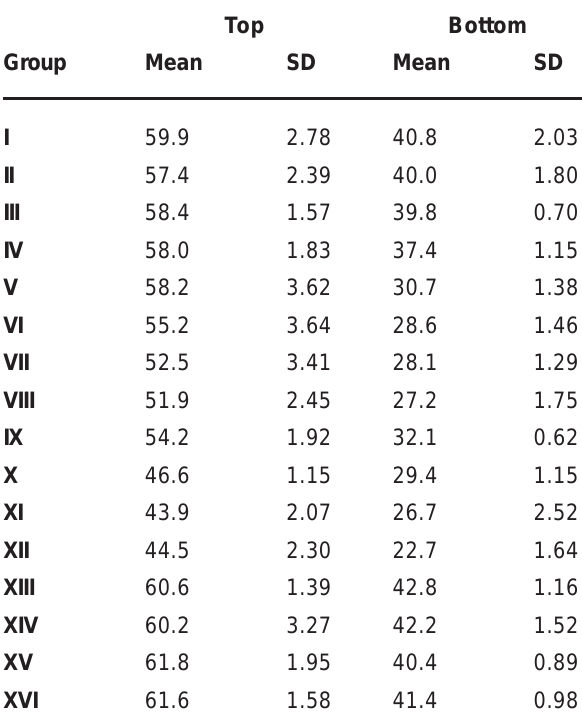
TABLE 1- Original means of microhardness and standard deviation presented by the study groups on the top